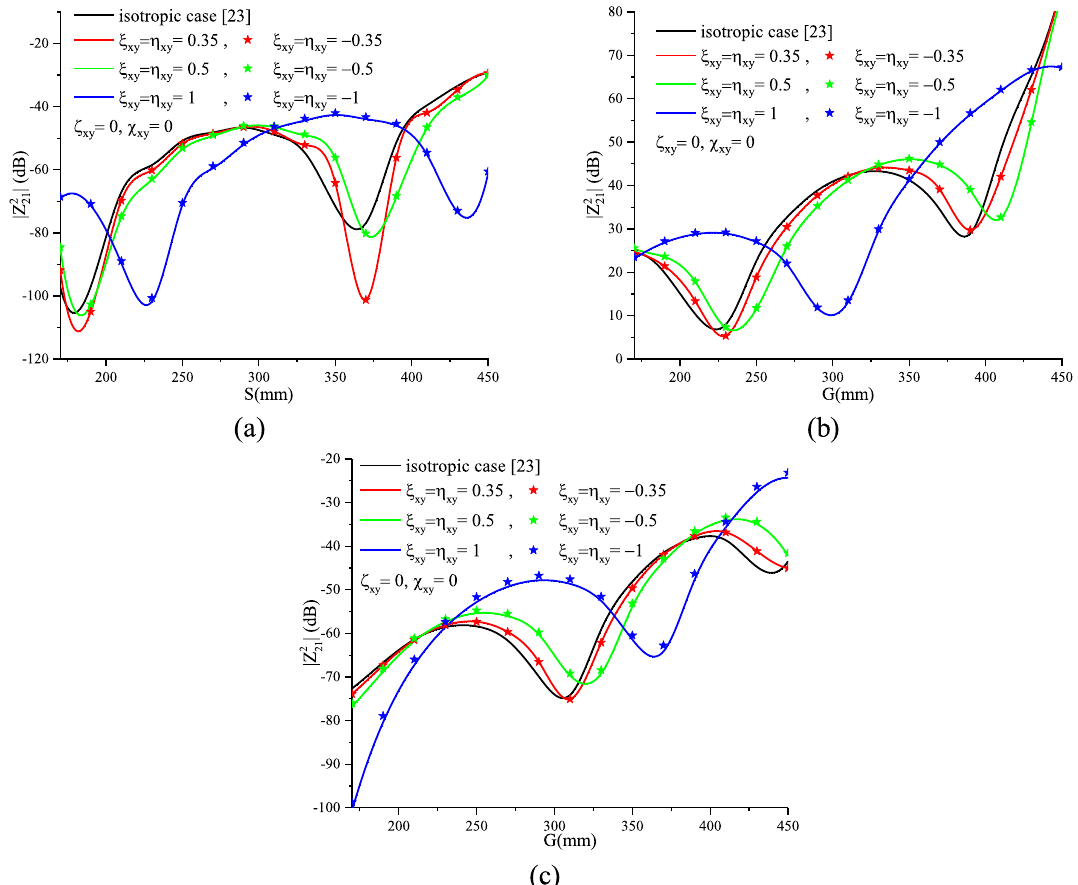
Figure 14. Chiral effect on the mutual coupling of an ( a ) broadside, ( b ) collinear and ( c ) echelon